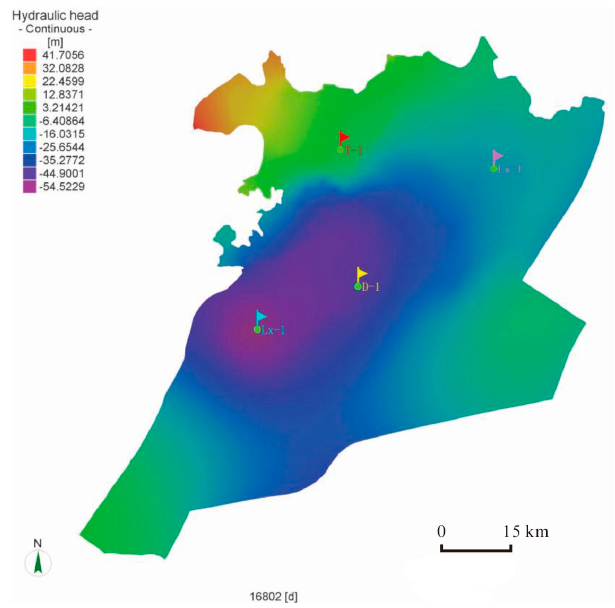
Figure 15. Distribution of hydraulic heads of groundwater at the end of the simulated period. Water 2019 , 11 , x FOR PEER REVIEW